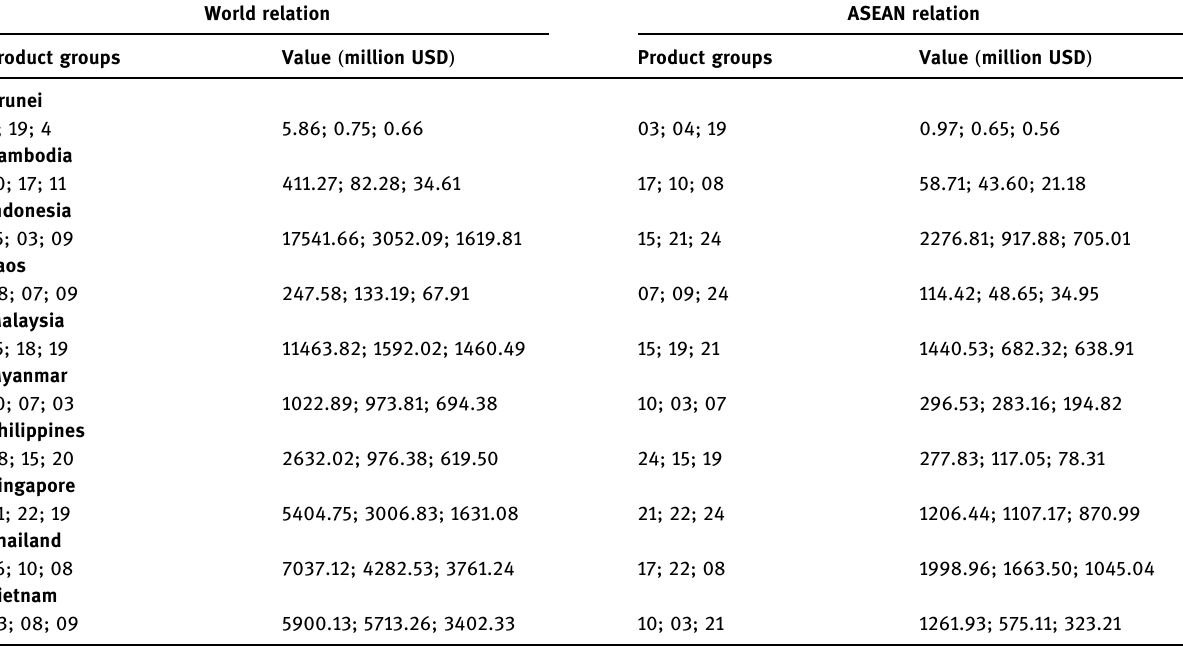
Table 1: TOP 3 product groups in terms of value on country level,